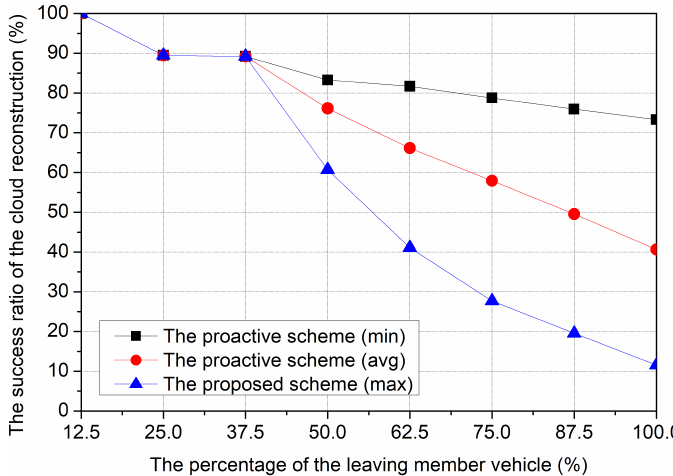
Figure 7. The success ratio of the cloud reconstruction for the percentage of the leaving member vehicle.